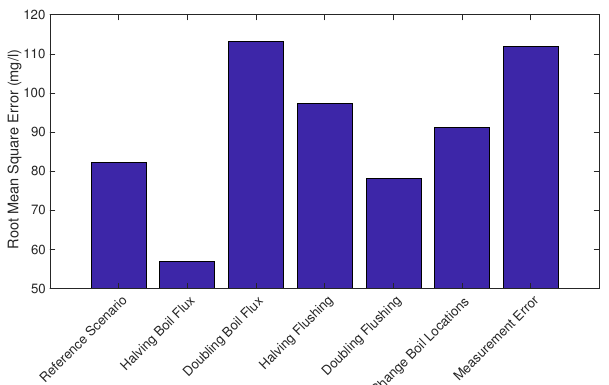
Figure 13. Robustness of sensor placement to model errors using RMSE as the performance